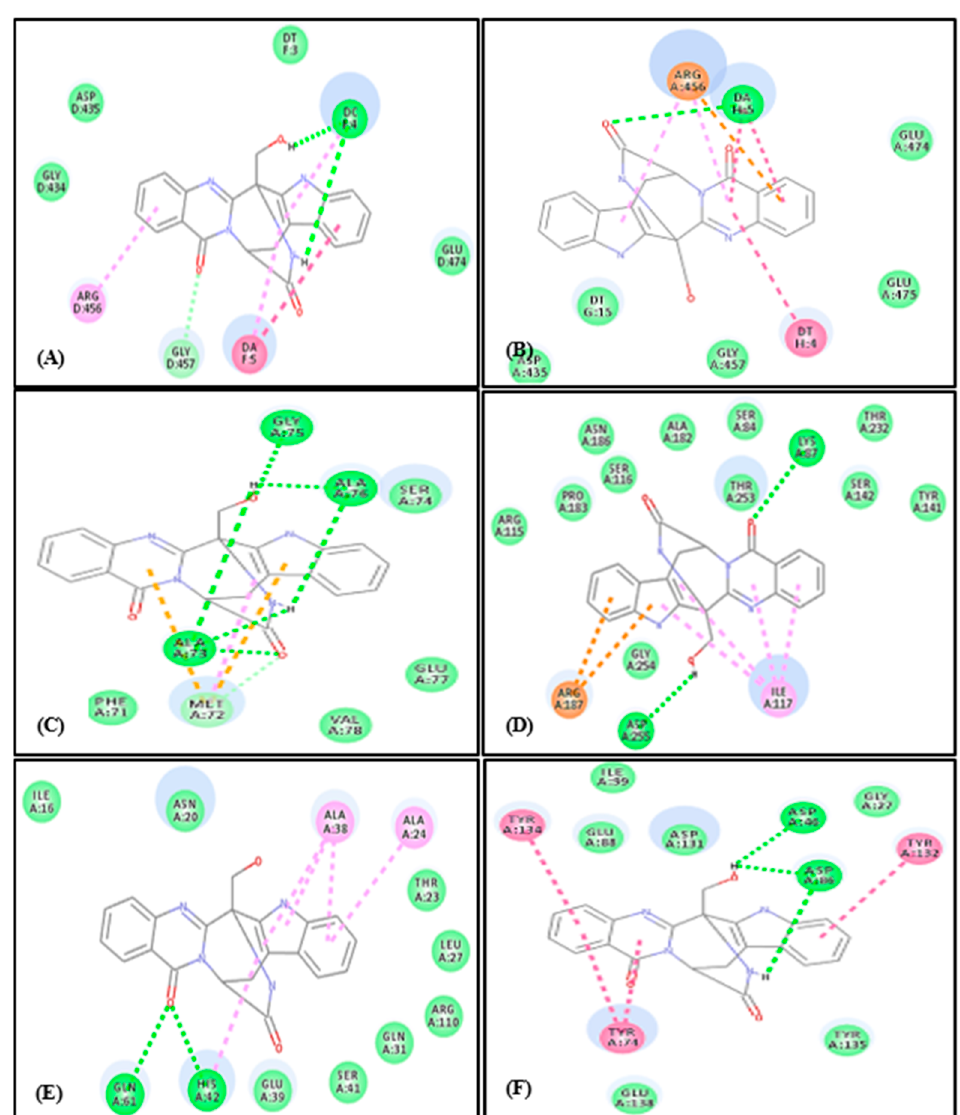
Figure 11. 2D binding mode of Fumigatoside E ( 28 ) in the binding sites of DNA-gyrase ( A ), topoisomerase IV ( B ), dihydrofolate reductase ( C ), β -lactamase ( D ), transcriptional regulator TcaR ( E ) and aminoglycoside nucleotidyl transferase ( F ). Dotted green lines indicate H-bonds; dotted light green lines indicate C-H-bonds; dotted purple lines indicate π -bonds; dotted orange bonds indicate salt bridge formation.